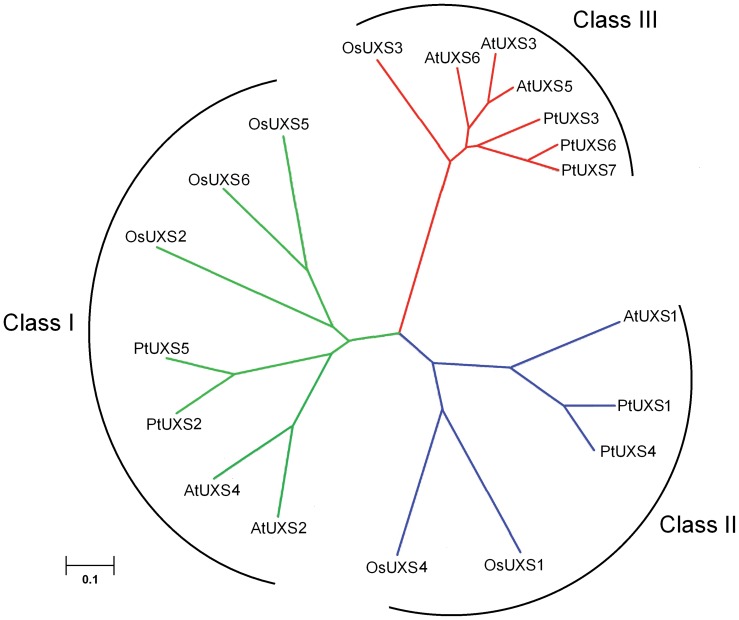
An unrooted phylogenetic tree of UXS members from poplar (PtUXS), Arabidopsis (AtUXS) and rice (OsUXS).Protein sequences of Arabidopsis UXS family members (AtUXSs) and rice UXS members (OsUXSs) were obtained from the (National Center for Biotechnology Information; http://blast.ncbi.nlm.nih.gov/Blast.cgi ).